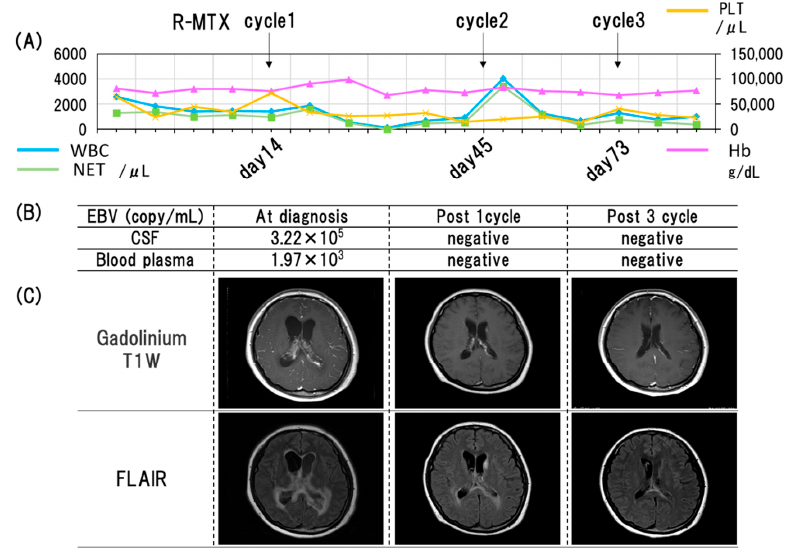
Figure 5. ( A ) The clinical course of this case. The X axis indicates the time (days). WBC (white blood cells), Hb (hemoglobin), PLT (platelets), NET (neutrophils), R (Rituximab), MTX (Methotrexate). ( B ) The detection of Epstein–Barr virus (EBV) by PCR analysis from cerebrospinal fluid and blood plasma and ( C ) MRI findings at the indicated